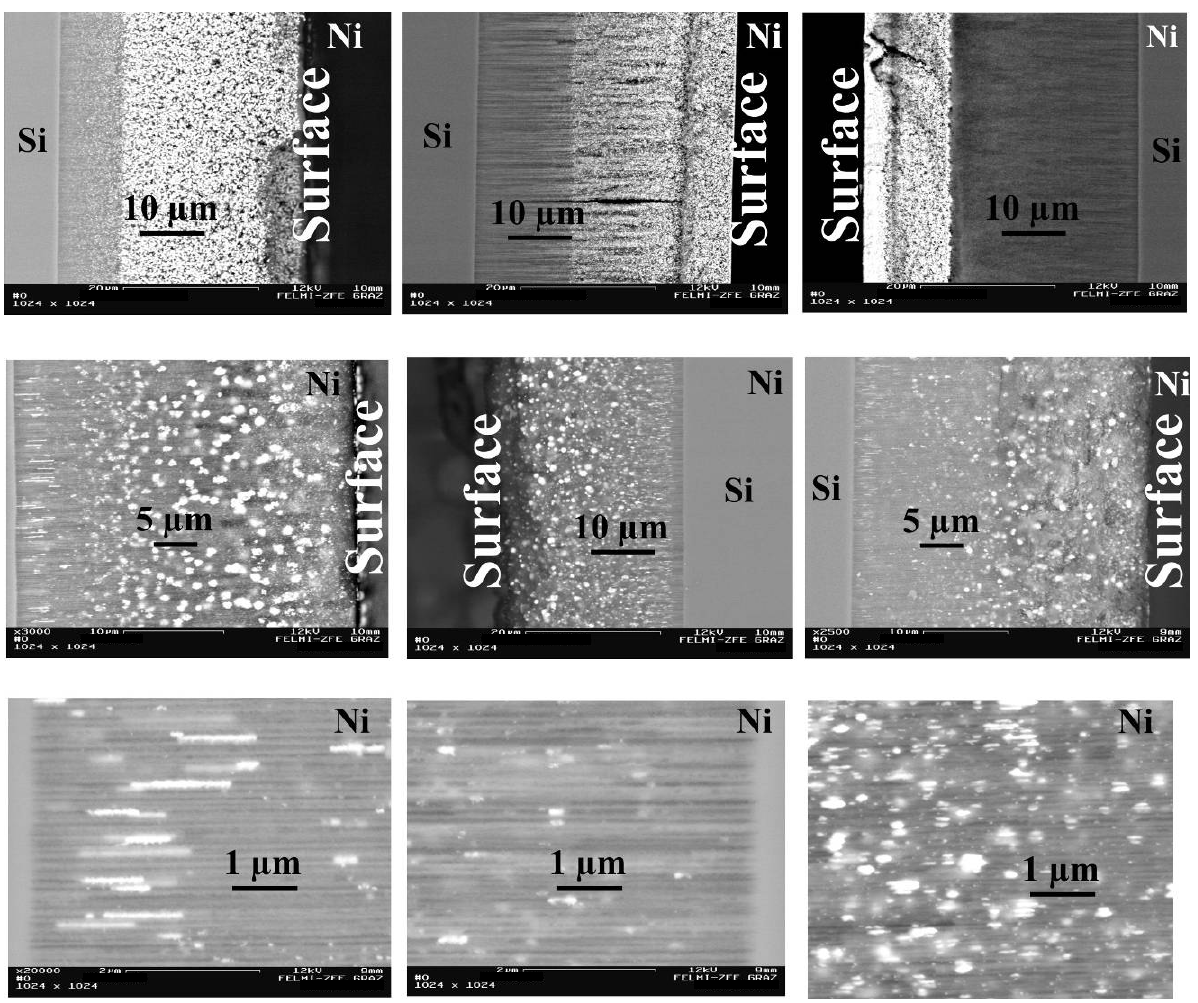
spatial distribution of the deposited metals varies between 2/3 to 1/3 of the porous layer. Second row: the porous layers are filled between surface and bottom of the pores but the shape of the precipitated Ni-structures differs. Third row: zoomed areas of row